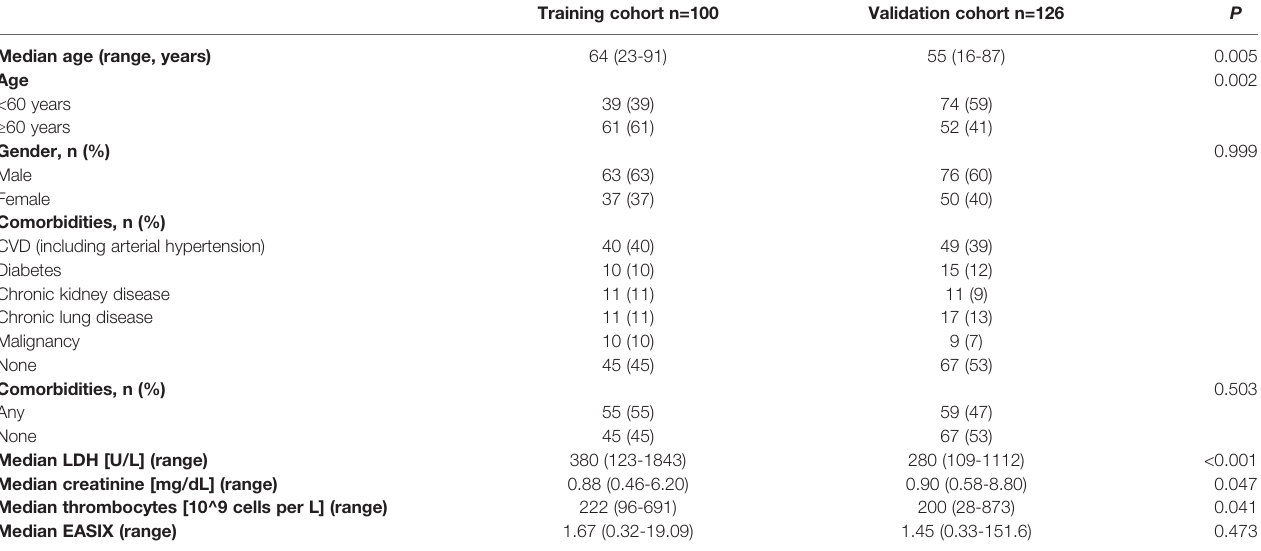
TABLE 1 | Patient